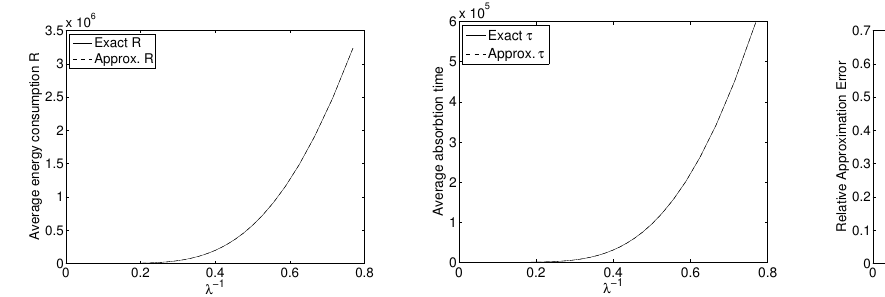
Figure 1: Exact and approximate Figure 2: Exact and approximate Figure 3: Relative approximation er-